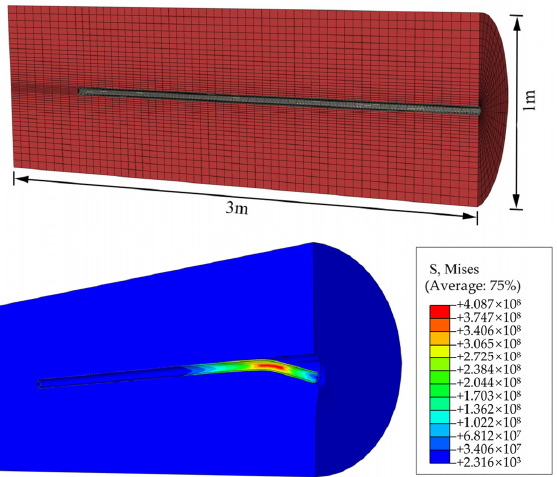
Figure 8. Simulation of deformation characteristics of vertical bearing capacity of foot steel pipe end. Figure 9. Simulated stress deformation curve of steel pipe under end load.